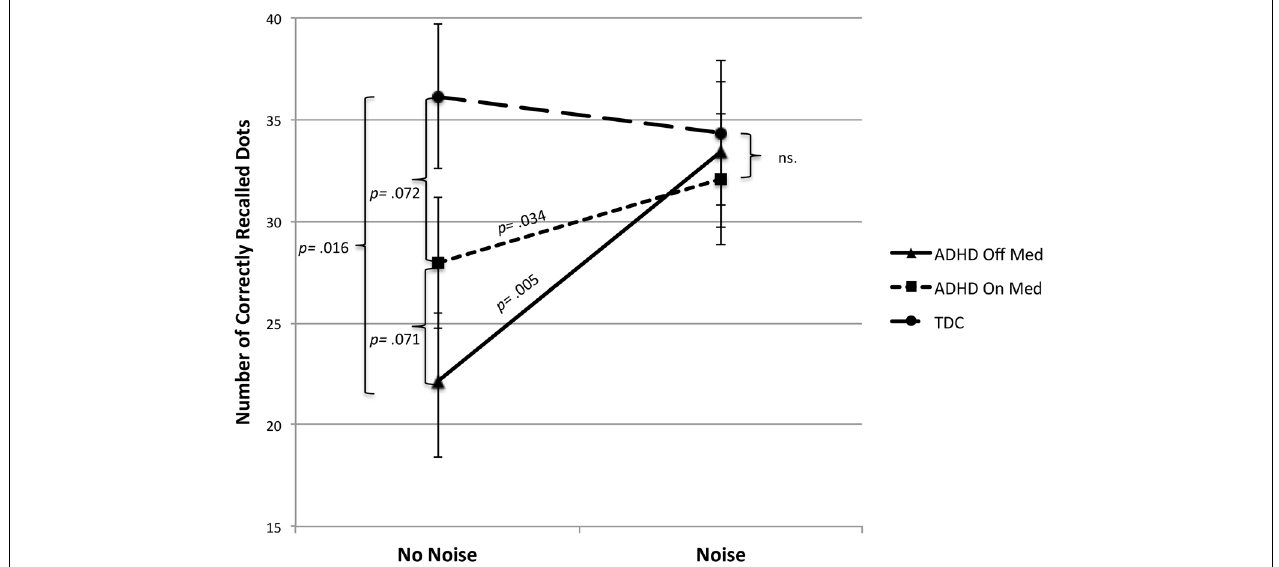
FIGURE 1 | Number of correctly recalled dots on a visuo-spatial task as a function of medication and noise in ADHD. As a comparison the performance of TDC is shown as a function of noise; test occasion is counterbalanced for the TDC group. White noise 79–80 dB; TDC, typically developed children; p -values are written in the graph for significant and trend significant differences.